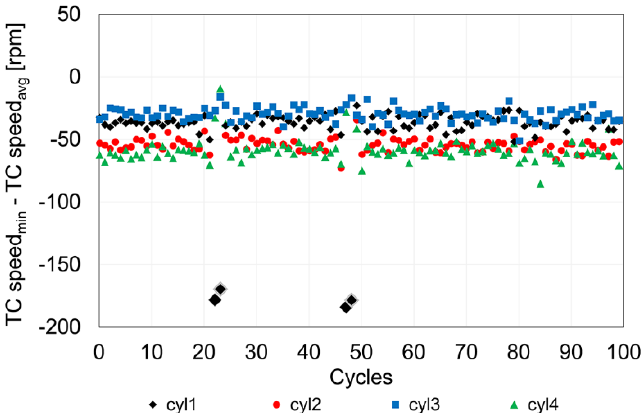
Figure 25. Minimum of the instantaneous TC speed subtracted of the average value calculated for each